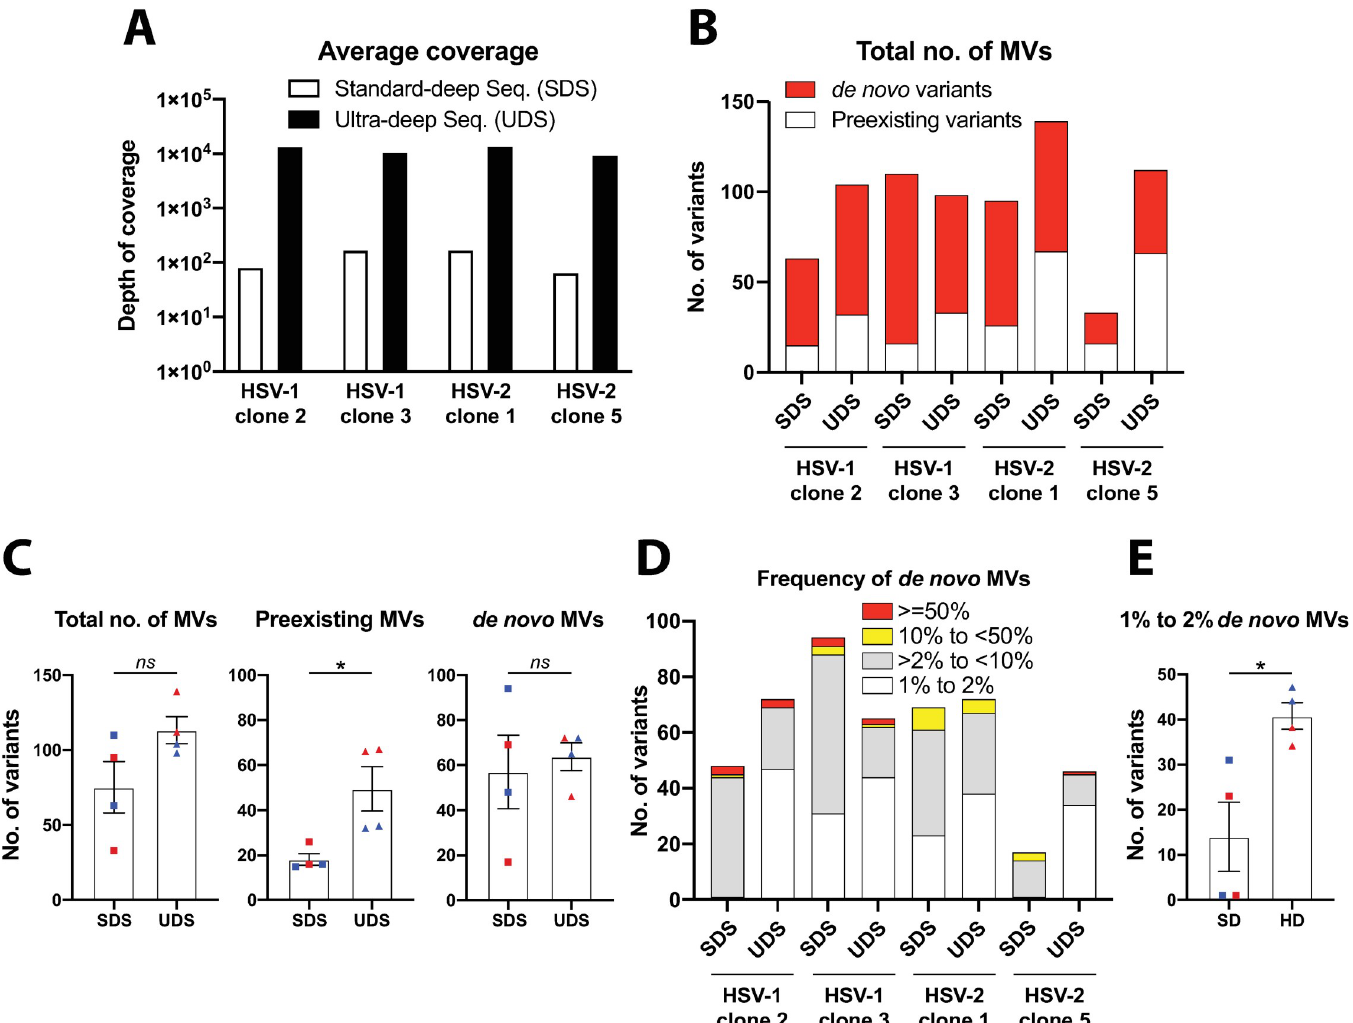
Fig 3. Comparative variant analysis from standard- and ultra-deep sequencing data of two plaque-isolated HSV-1 and HSV-2 clones. (A) Histograms show the average depth of coverage per genomic position of reads alignments from standard-deep sequencing (SDS, white bars) and ultra-deep sequencing (UDS, black bars) for each viral clone. (B) Histograms bar plot total number of MVs observed after variant analysis of SDS and UDS data in each viral clone, discriminating between preexisting MVs found in the corresponding original stock (white) and de novo appearance (red). (C) The number of total, preexisting, and de novo MVs detected in each clone from SDS, and UDS data are grouped and graphed (blue shapes for HSV-1, red for HSV-2 clones), showing mean +/- SEM (ns p > 0.05, � p = 0.029 by two-tailed Mann– Whitney U -test). (D) Number of de novo MVs observed after variant analysis of SDS and UDS data in each viral clone, stacked by frequency ranges. SNPs and InDels were combined for this analysis. (E) de novo MVs with a frequency between 1% to 2% detected in each clone from SDS, and UDS data are grouped and graphed (blue shapes for HSV-1, red for HSV-2 clones), showing mean +/- SEM ( � p = 0.029 by two-tailed Mann–Whitney U -test). See Sheets E and F in S1 Table for full lists of MVs position and frequency